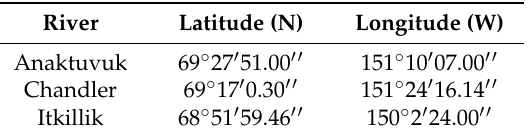
Figure 1. Study sites on the Alaska North Slope. South watershed boundaries are located on the Brooks Range. Table 1. Coordinates of gauging sites.